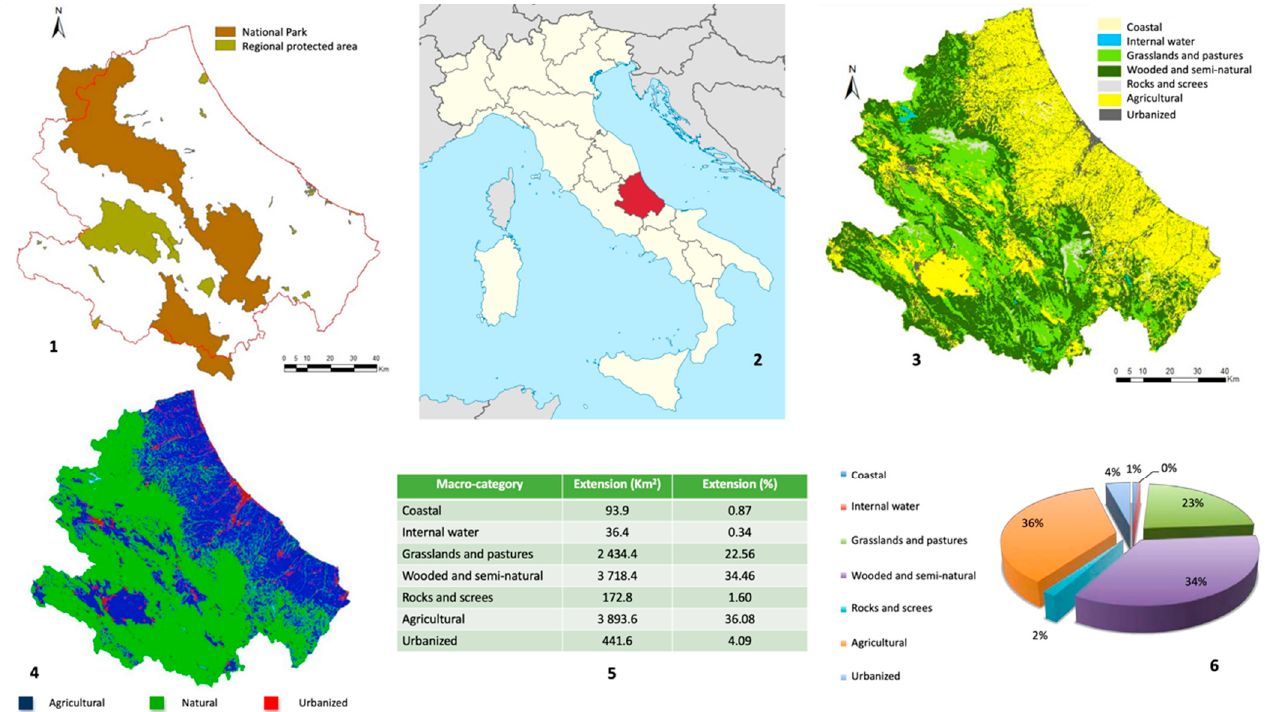
Figure 1. The main environmental characteristics of the Abruzzo region. Protected areas in the region ( 1 ); Abruzzo region in the Italian peninsula ( 2 ); environmental macro environmental categories ( 3 ); distribution of the type of environment within the region ( 4 ); percentage distribution of the 7 macro-categories of land use of the regional territory ( 5 , 6 ). ( 2 ) From https://it.wikipedia.org/wiki/Abruzzo#/media/File:Abruzzo_in_Italy.svg (accessed on 23 March